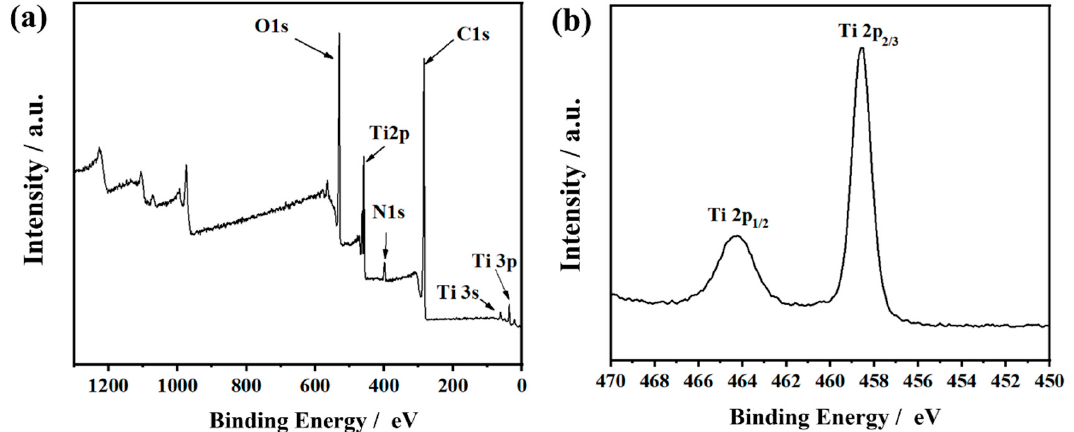
Figure 6. XPS spectra of ( a ) TiO 2 /CRFs and ( b ) Ti 2p.